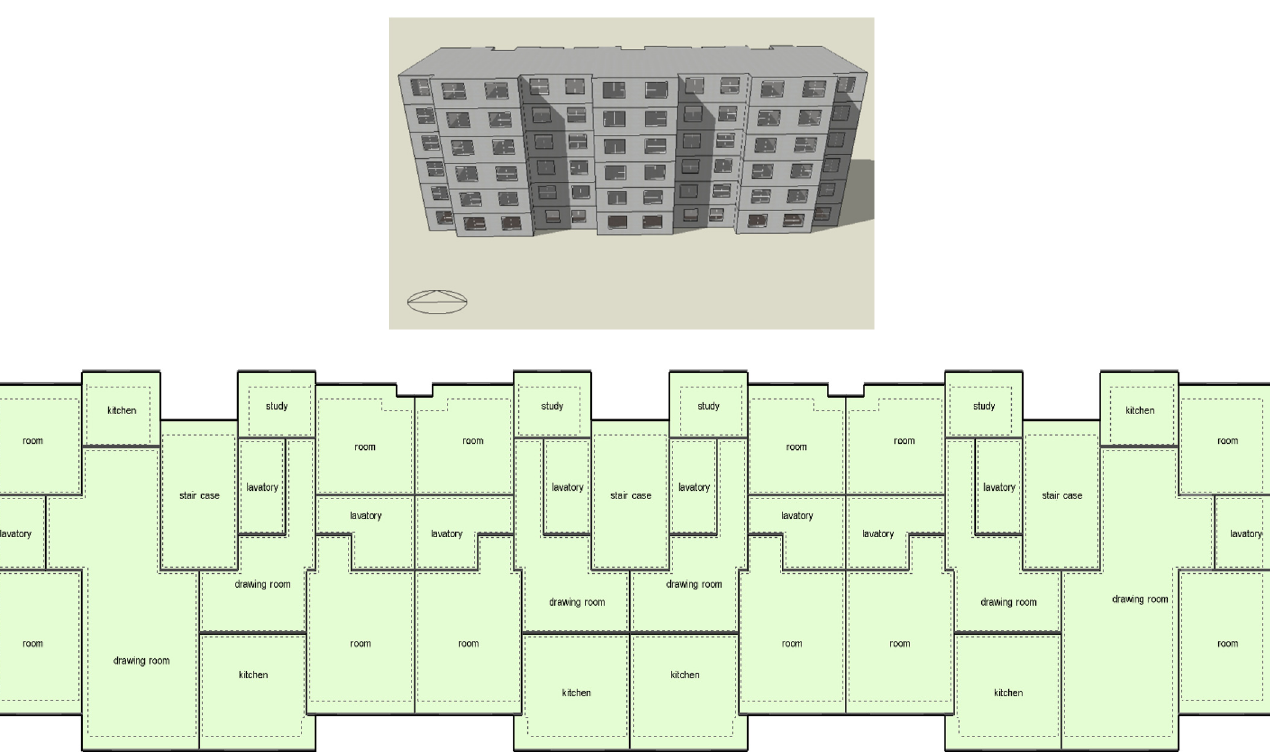
Figure 3. Simulation model of a residential building.